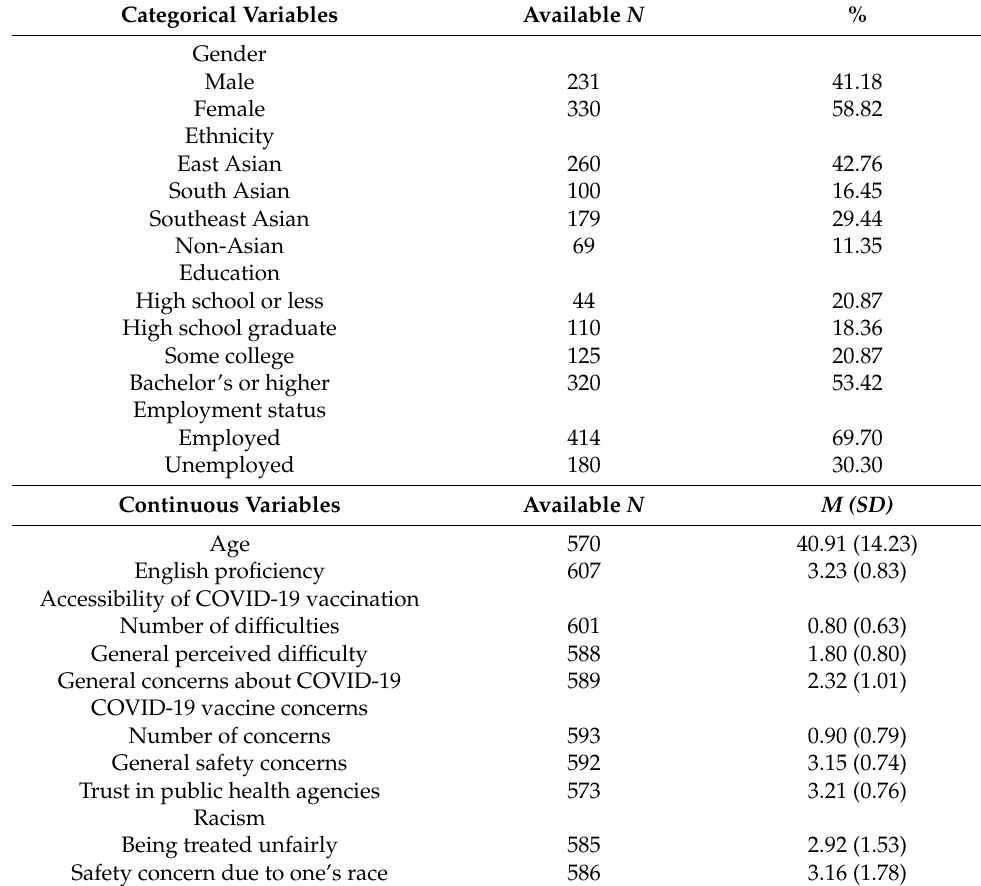
Table 1. Descriptive statistics for study variables (total N = 617).